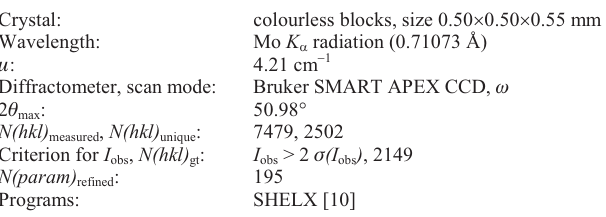
Table 2. Atomic coordinates and displacement parameters (in Å 2 )